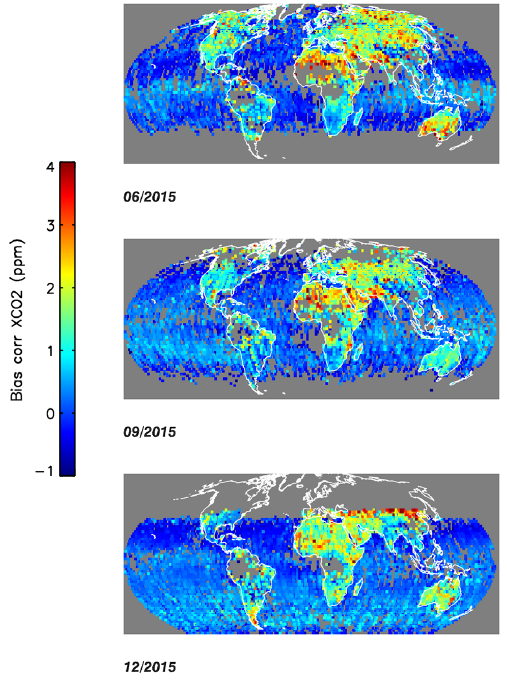
Figure 9. Maps of the bias correction applied to the X CO Statistics are provided for 2 ◦ by 2 ◦ bins for data selected with the data quality flag.